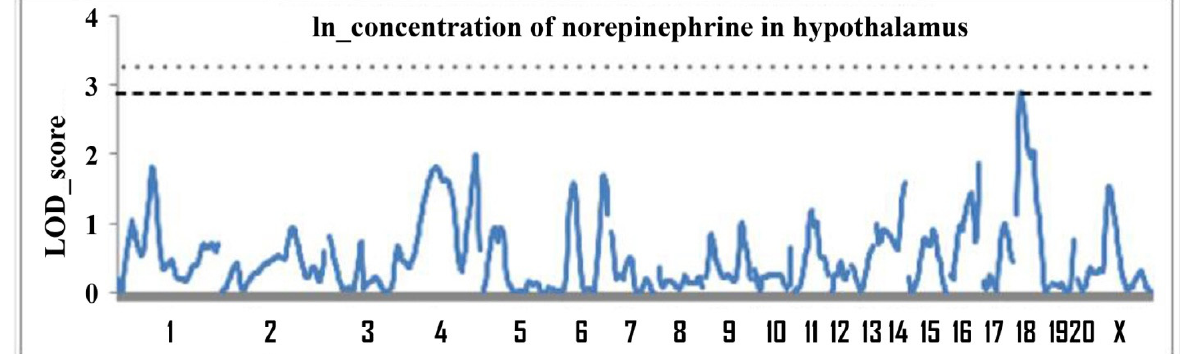
Figure 1. Genome-wide LOD ( logarithm of odds) plots for concentration of norepinephrine in the hypothalamus in male rats F 2 (ISIAH × WAG) aged 6 months. The X axis shows the chromosome numbers. Lines show the level of experimentwise threshold: the dashed line corresponds to p = 0.05, the dotted line corresponds to p = 0.025.